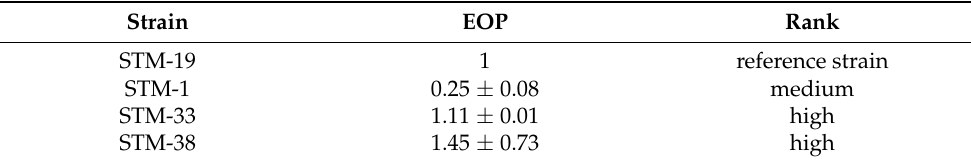
Table 2. Efficiency of plating (EOP) of CUB19 phage dilutions against target bacteria. EOP values were determined using STM-19 as reference strain. Values are expressed as average ± standard deviation.